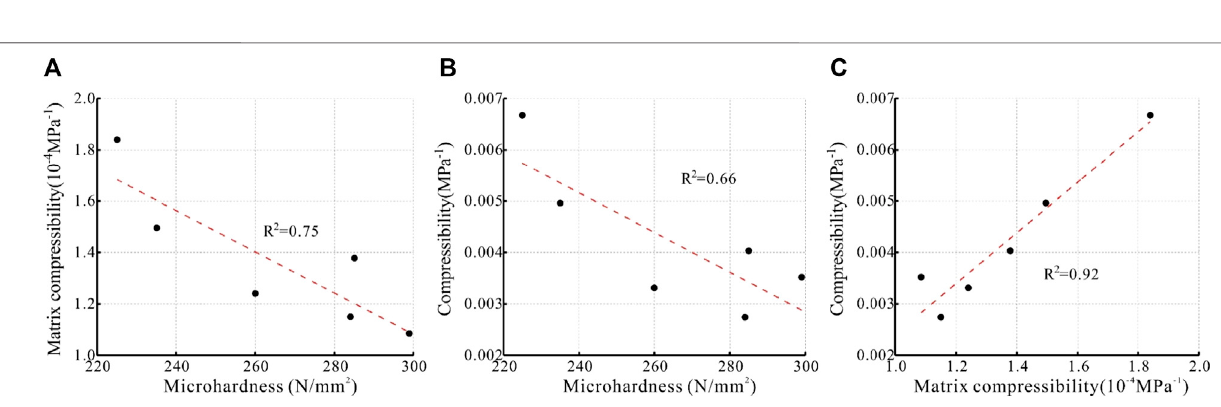
Frontiers in Earth Science |